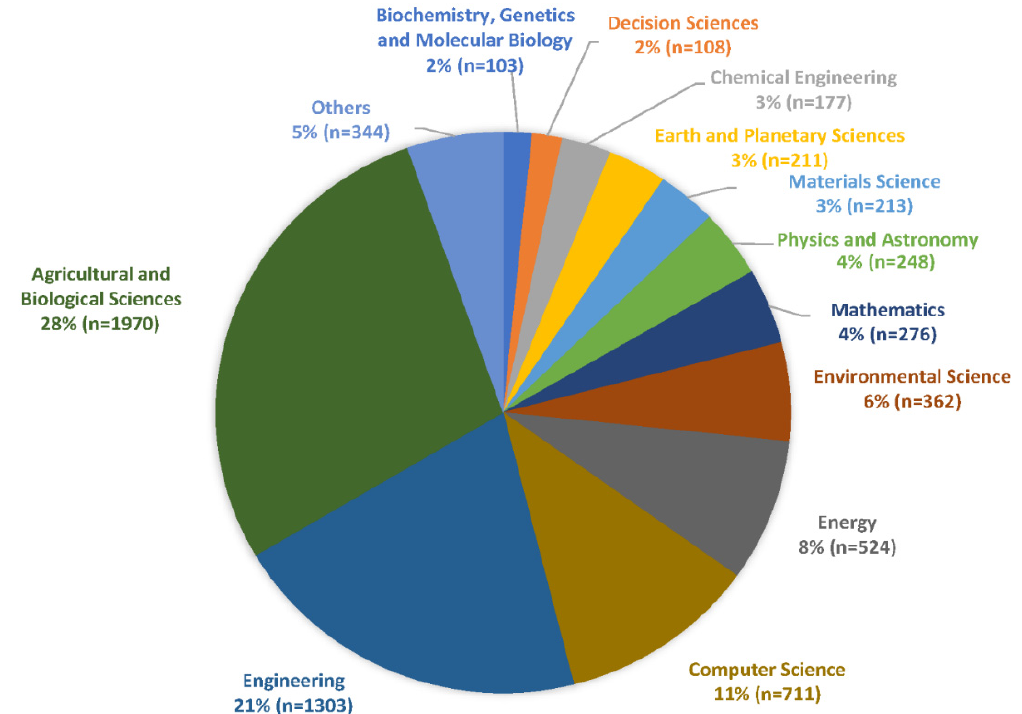
Figure 3. Subject areas of the publications on greenhouse engineering.